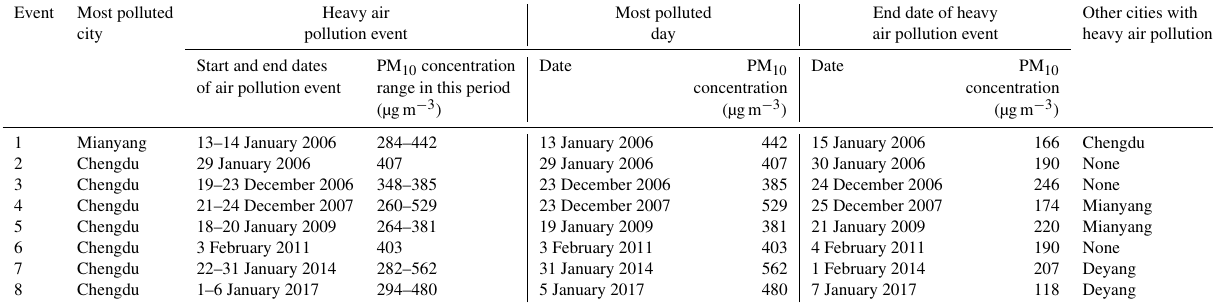
Figure 4. Weather maps at 700 hPa for event 8 at (a) 02:00BST on 2 January 2017, (b) 14:00BST on 2 January 2017, (c) 08:00BST on 4 January 2017, and (d) 02:00BST on 5 January 2017. The blue lines are isopleths of geopotential height, the red lines are isotherms, and the black arrows are wind vectors. The green dots show the location of the urban agglomeration. Table 1. Overview of the eight heavy air pollution events affected by dry low-pressure